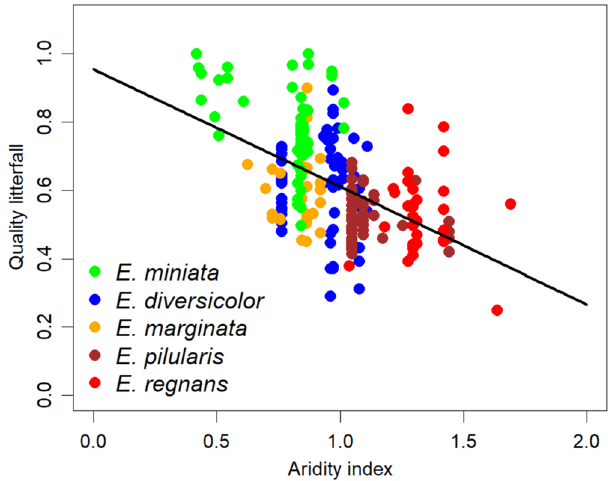
Fig. 4 | Relationship of litterfall quality (Q lf ) to Aridity Index (AI) for fi ve representative eucalyptcommunities.